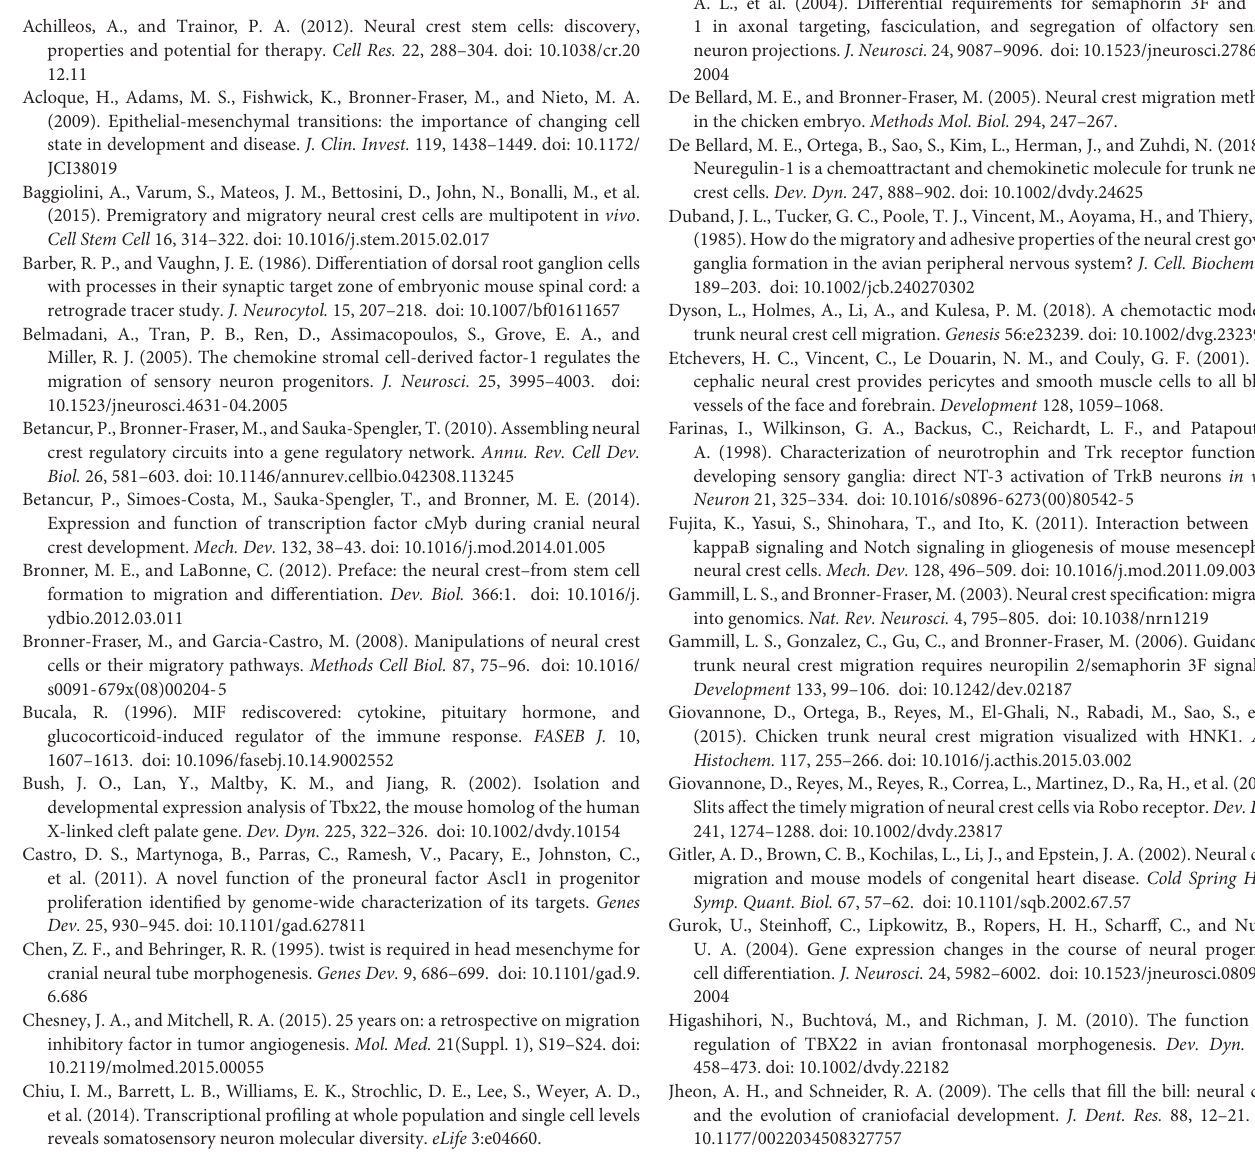
TABLE S1 | GO genes from HH16/HH19 macroarray comparison. TABLE S2 | Genes from HH16/HH19 macroarray comparison. (A) HH19-HH16 UP: up-regulated genes between HH16 and HH19 (433). (B) HH19-HH16 DOWN: